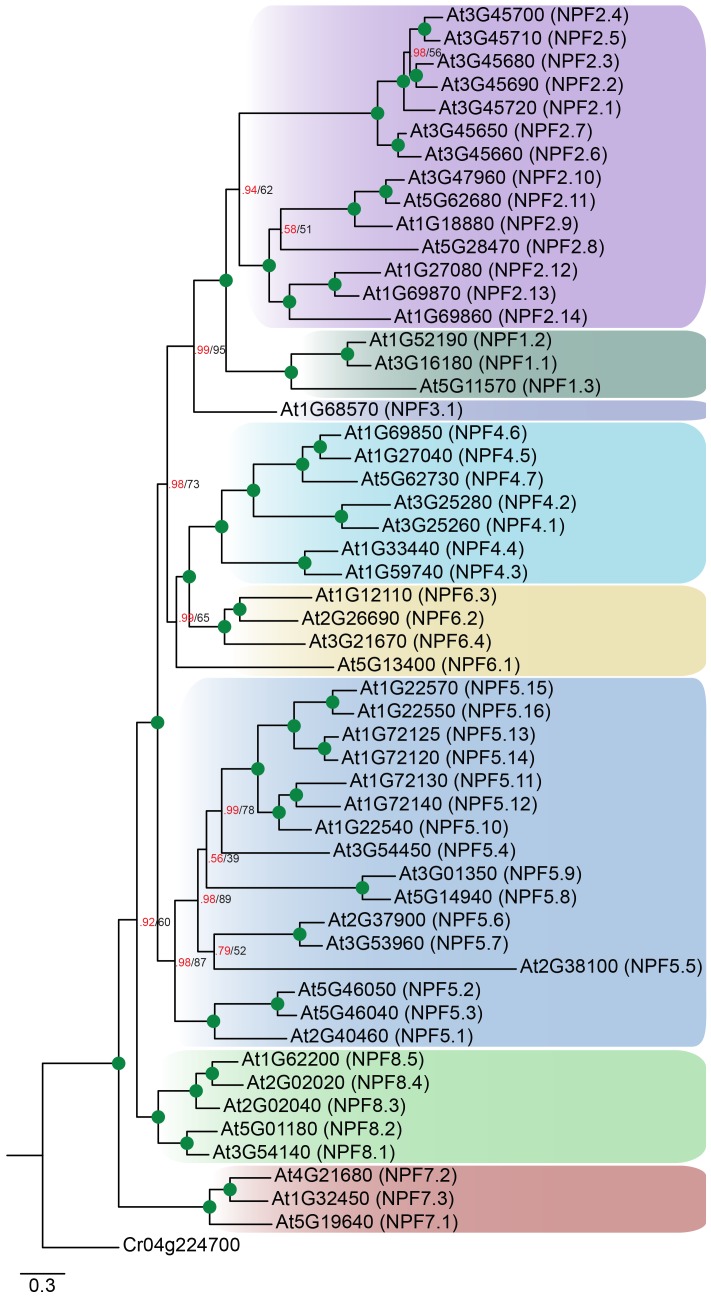
Non-reduced AtNPF tree.Bayesian inference (MrBayes) tree (s.d.< 0.01) of the A. thaliana NPF family with NPF names in parentheses as previously annotated (Léran et al., 2014). Green circles at nodes represent a posterior probability of 1 (maximum is 1). Values at nodes separated by a backslash represent MrBayes values below 1 in red, followed by RAxML generated bootstrap values in black (only reported when Mrbayes value is below 1). Scale bar indicates number of substitutions per site.